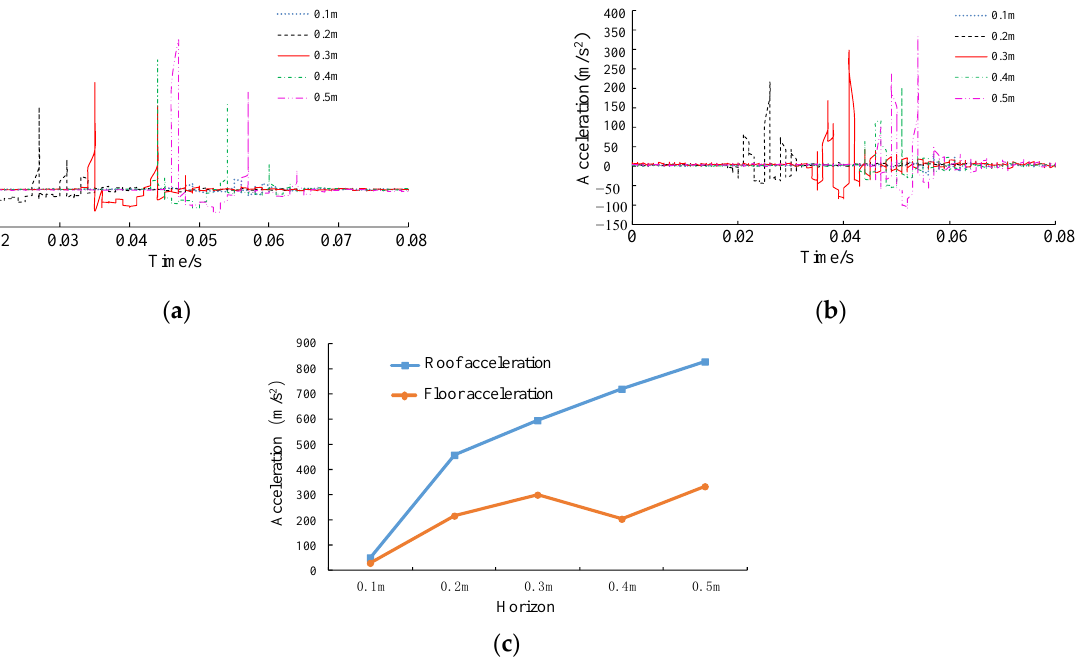
Figure 12. Acceleration response characteristics of coal and rock in the fifth layered test. ( a ) Acceleration at the roof of surrounding rock; ( b ) Acceleration at the bottom of the roadway; ( c ) Peak acceleration at different energies.